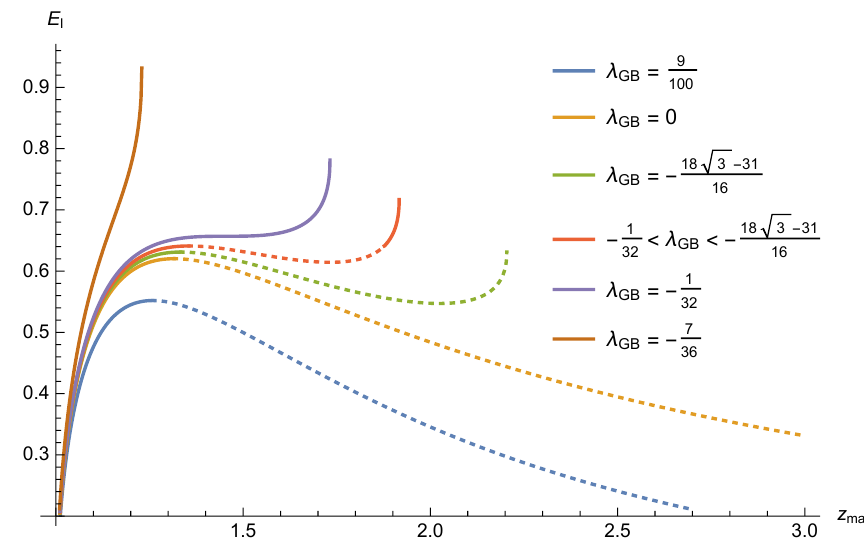
Figure 13 . Conserved quantity E I (4.15) as a function of z max for d = 4 . We have z h ≤ z max ≤ z s for negative λ GB , where z h = 1 denotes the horizon and z s denotes the black hole singularity (4.26). The extremal surface is well-defined only for the z max in the solid lines. As for the z max in the dotted lines, the entropy (4.11) and time (4.16) become